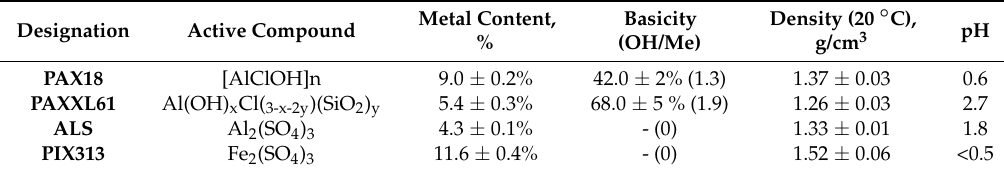
Table 1. Properties of Membrane Flux